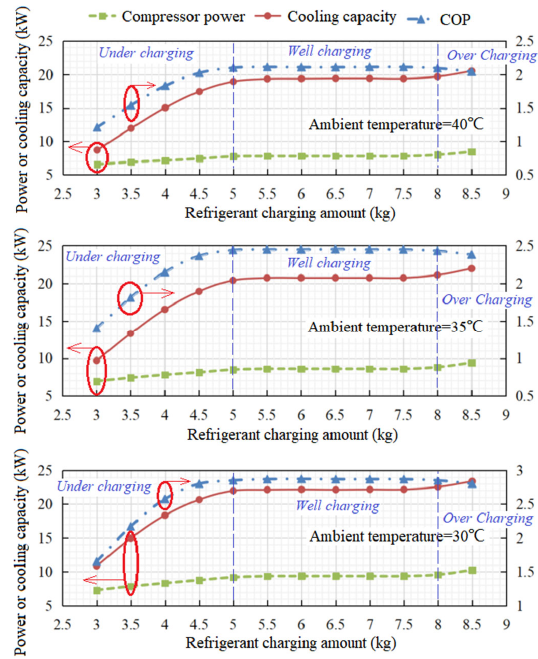
Figure 9. System performance versus refrigerant charging amount under different ambient temper- atures.